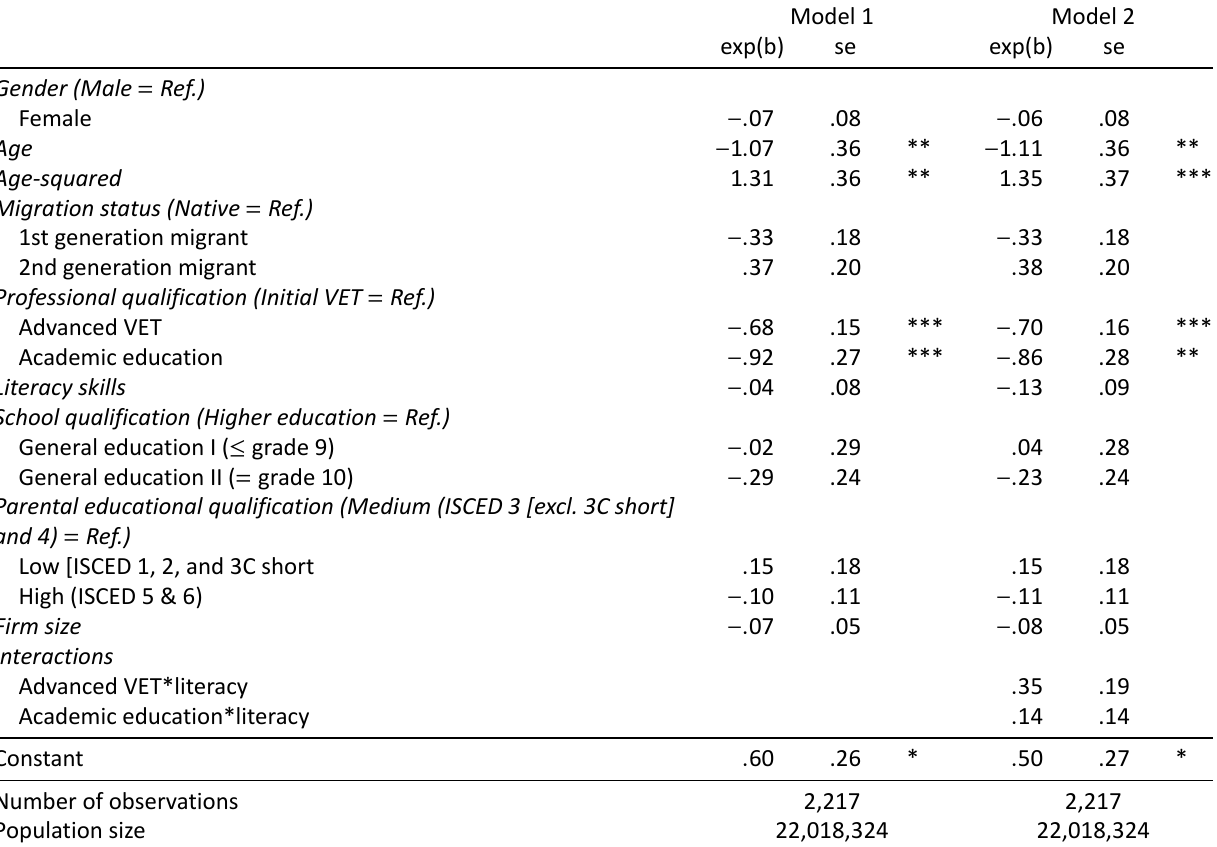
Table A4. Full regression results for abilities-demands match, logit